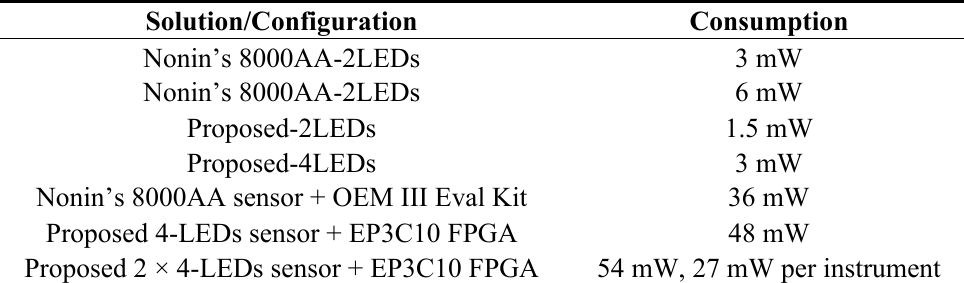
Table 3. Comparison of power